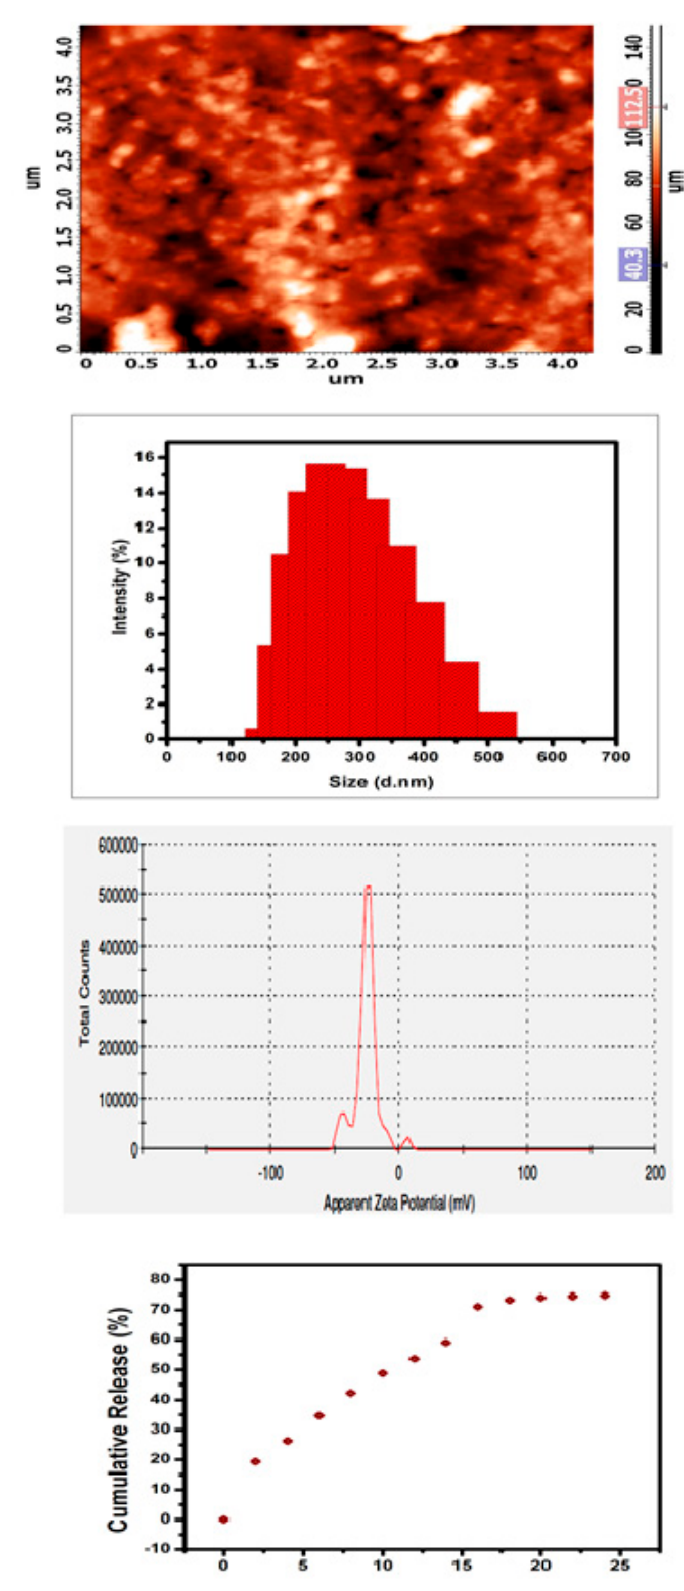
Figure 2. ( A ) Atomic Force Micrographs (AFM) of SEMG (2D and 3D image), ( B ) particle size distribution of the SEMG, ( C ) zeta potential measurement of SEMG, ( D ) In vitro release kinetics of Methyl Gallate (MG) from SEMG.